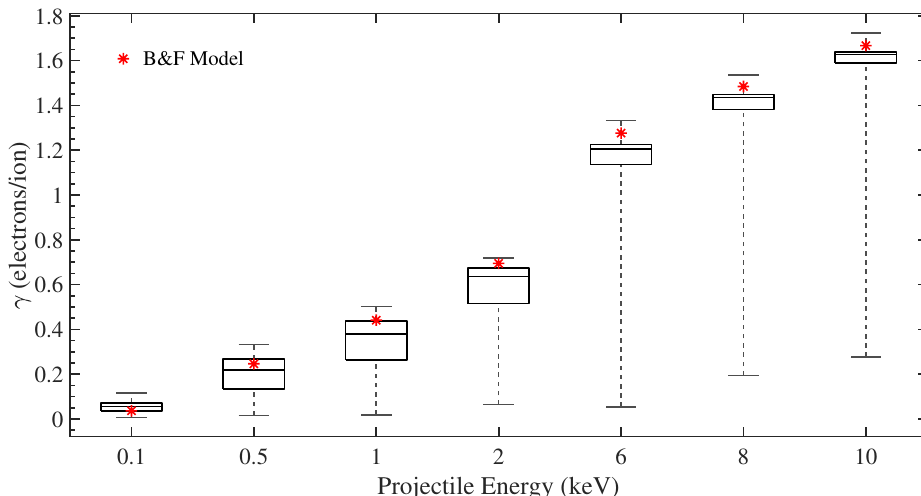
Figure 5. Box plots of TRIM model ion-induced electron yield distributions as a function of energy for nitrogen ions impacting copper. Yield calculations using the B&F model, which assume no ion scattering, are also given at each energy. Outliers are included within the whiskers for